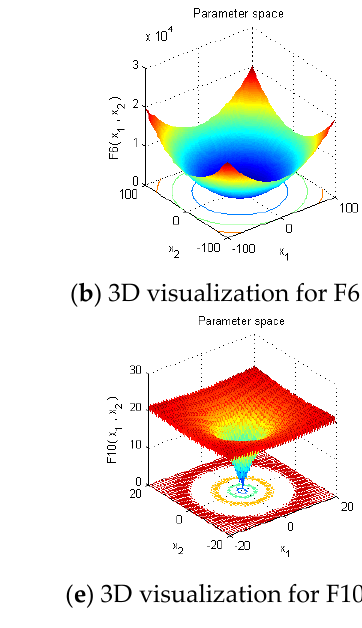
Figure 3. 3D visualization for 2D benchmark functions.